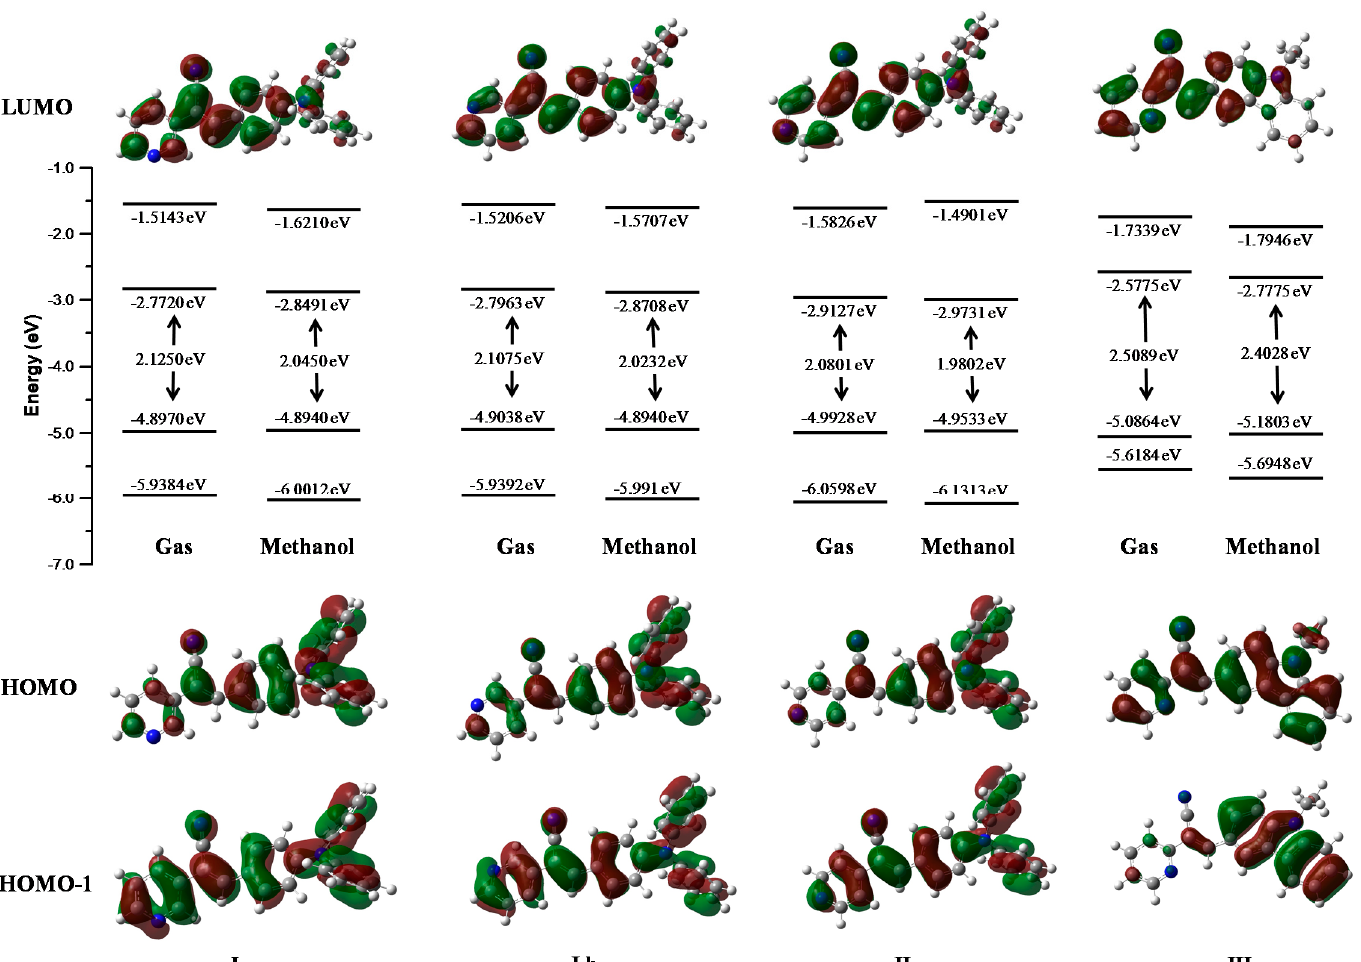
Figure 13. Molecular orbitals of compounds obtained in gas and methanol and phases at M06L/cc-pVDZ theory level.